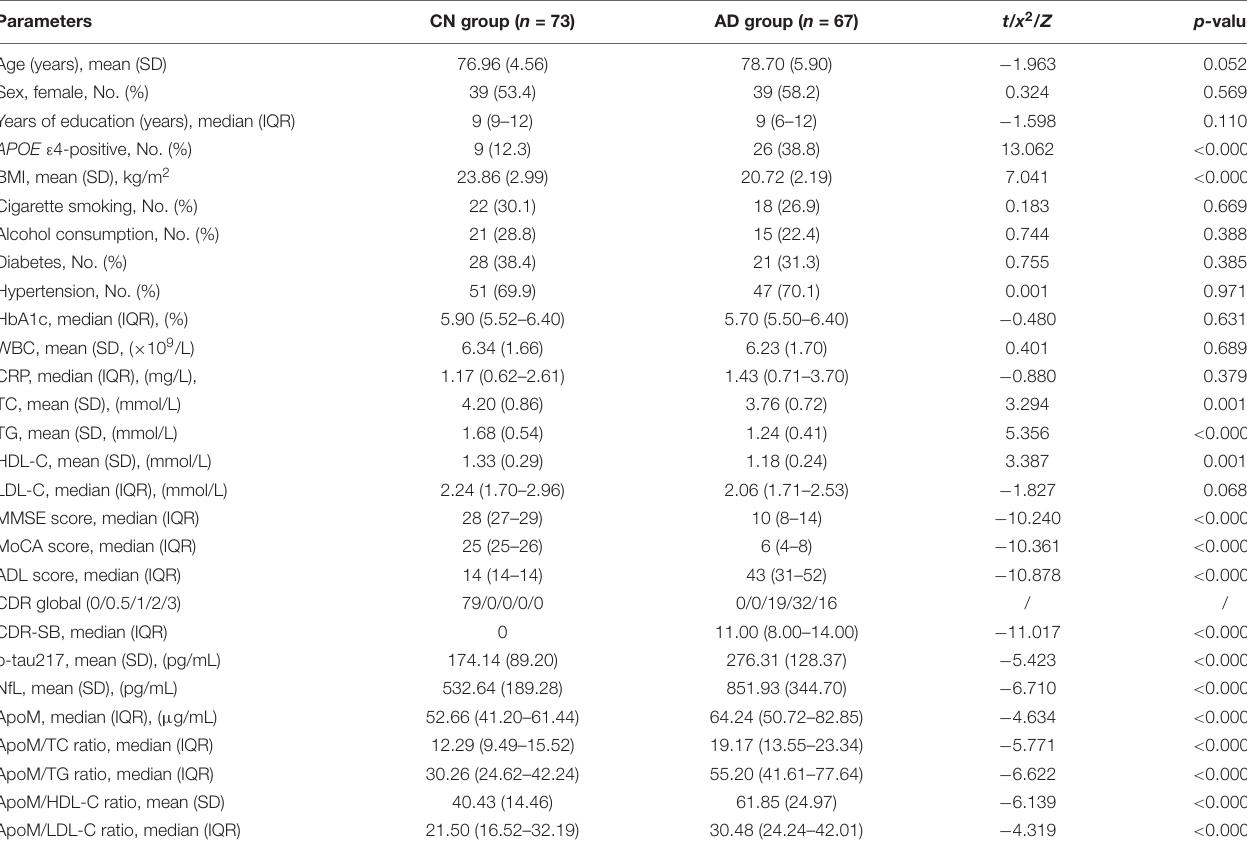
TABLE 1 | Demographics, clinical characteristics, and blood tests of all